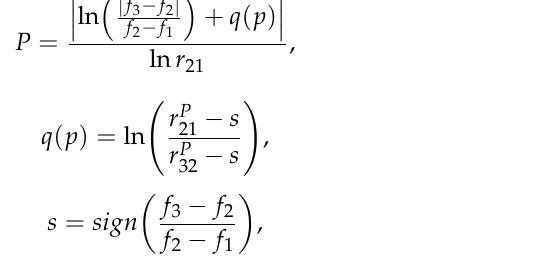
Table 3. Modelling conditions. Boundary Condition Inlet 3 500 Outlet 1